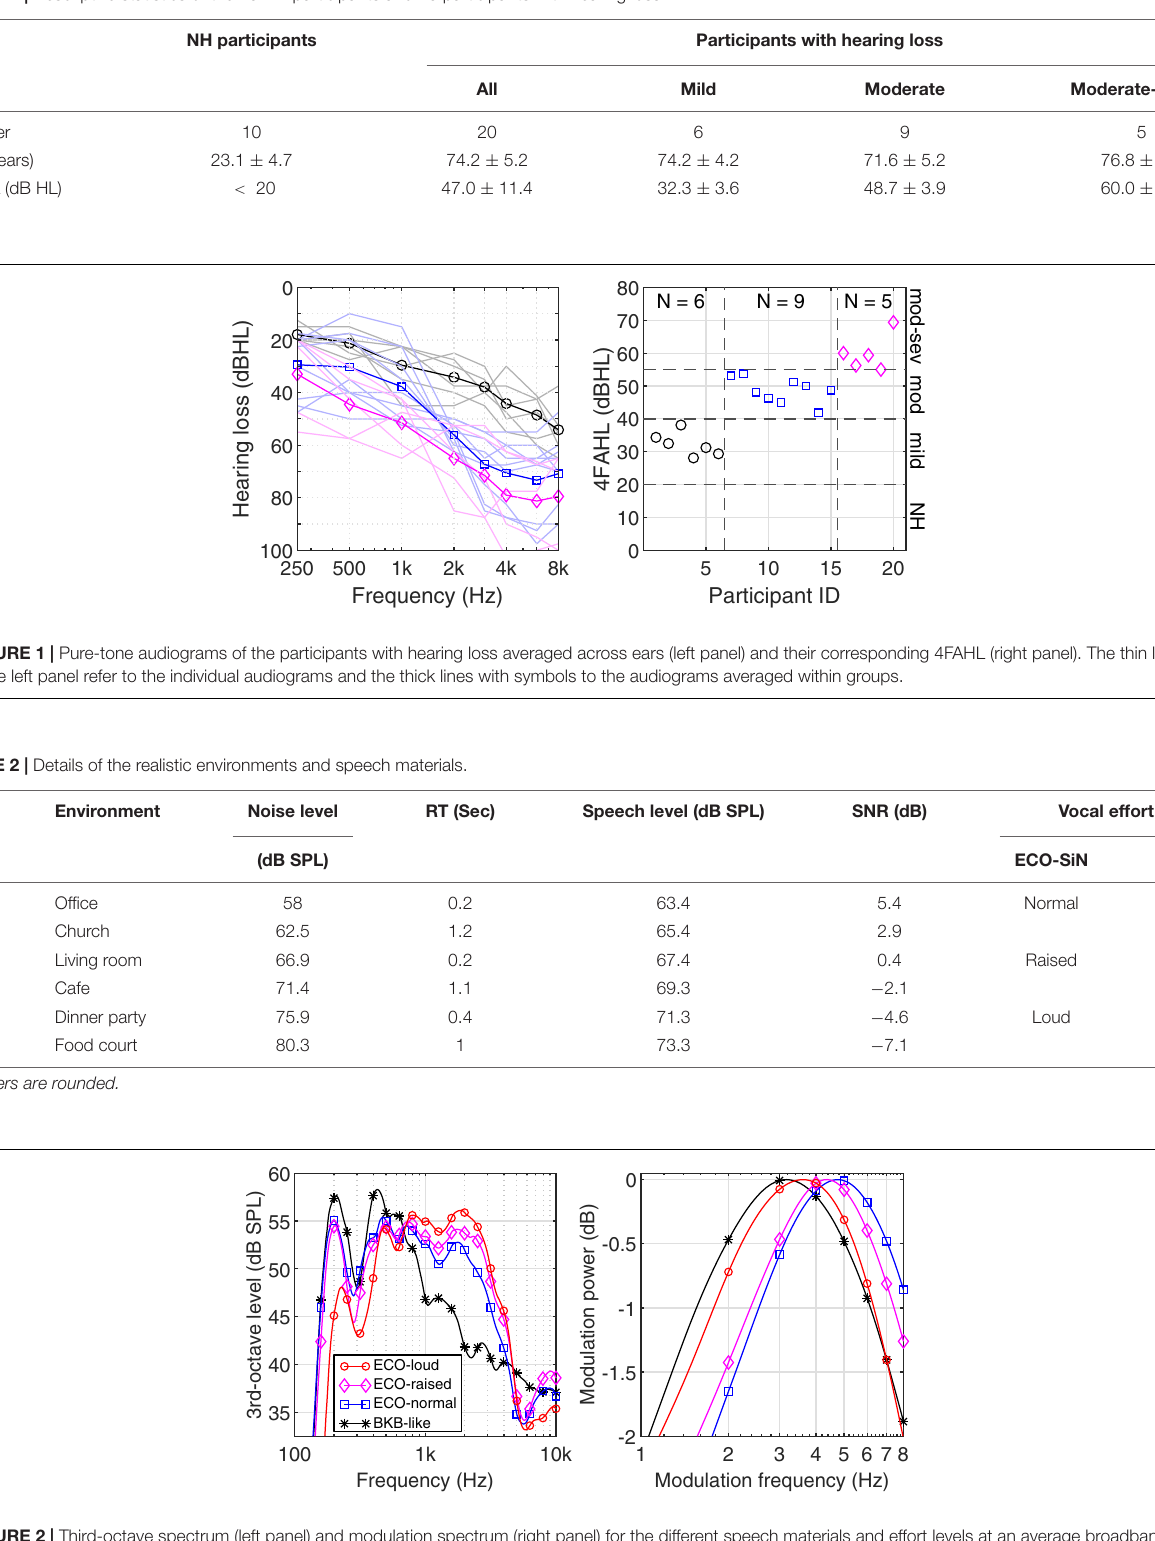
Frontiers in Neuroscience |